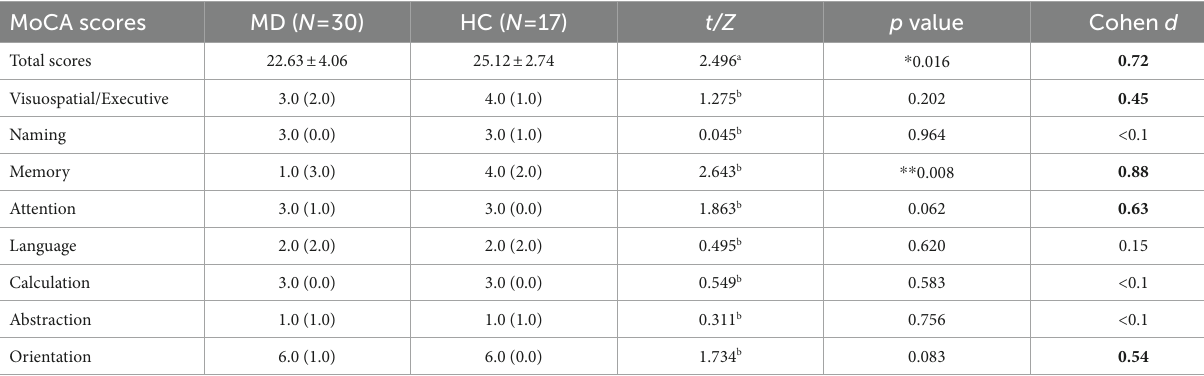
TABLE 2 Comparison of MoCA scores for MD and